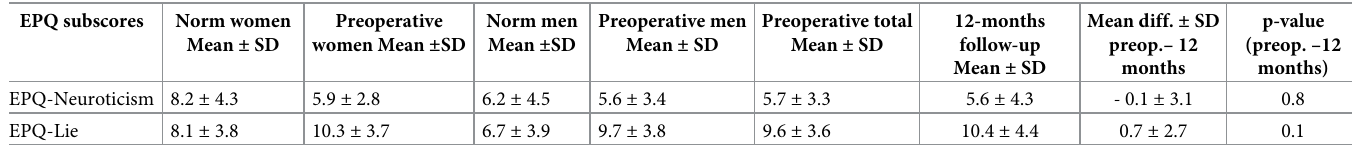
Table 4. Eysenck Personality Questionnaire (EPQ) scores of normative sample, and scores from preoperative and 12 months follow-up in our study population.